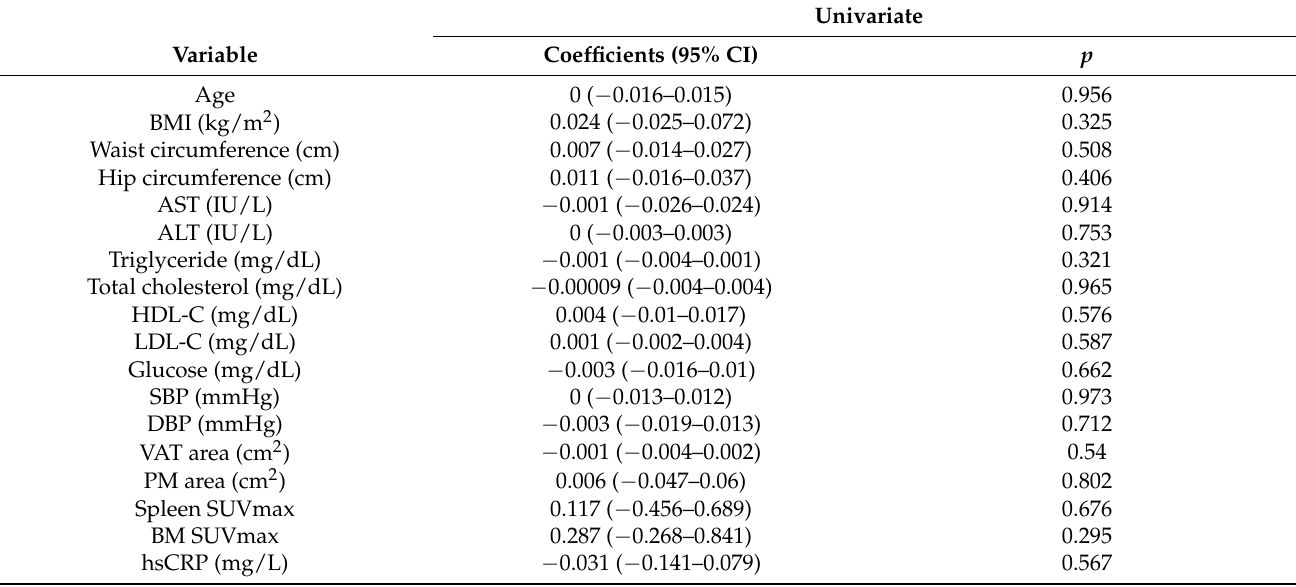
Table 5. Univariate analysis using PM SUVmax as dependent variable at